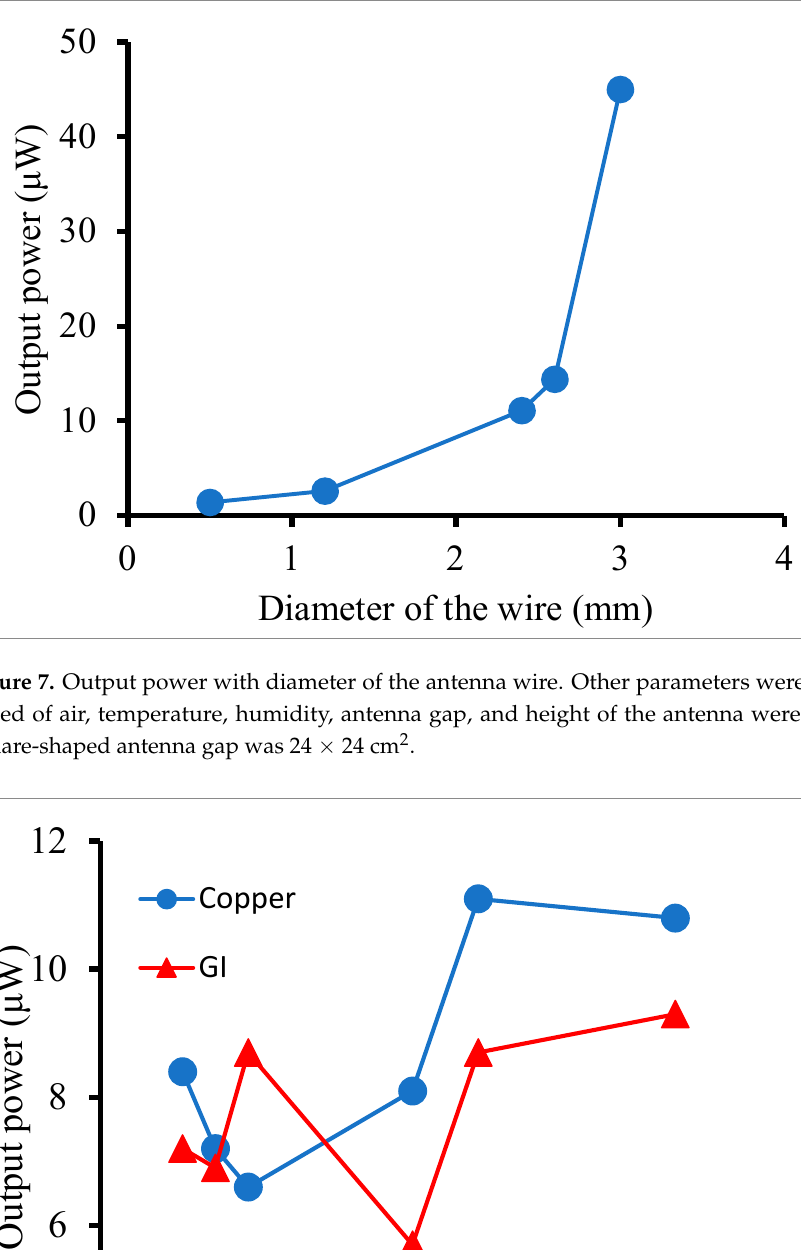
Figure 7. Output power with diameter of the antenna wire. Other parameters were constant. The speed of air, temperature, humidity, antenna gap, and height of the antenna were constant. The square-shaped antenna gap was 24 × 24 cm 2 .